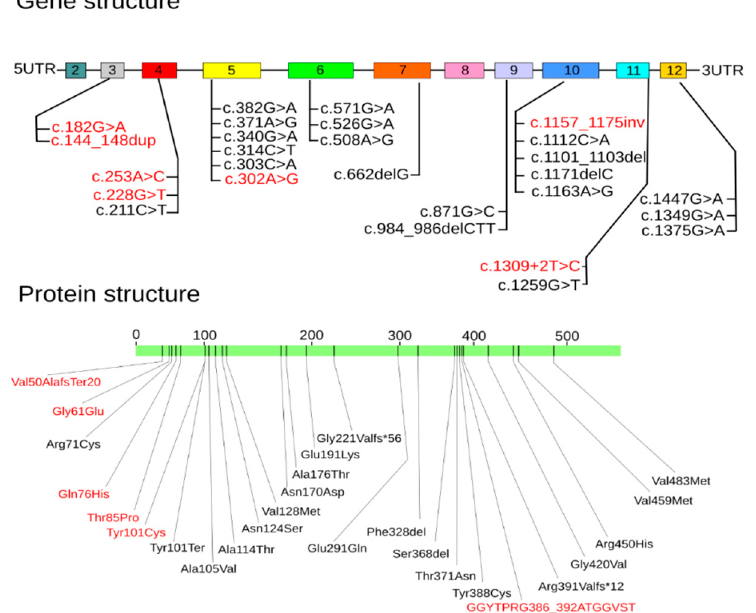
Figure 6. Distribution of genetic variants in the ALPL gene and amino acid substitutions in the TNSALP protein in Russian patients (compound heterozygotes and homozygotes only). Variants are highlighted in red, identified for the first time in the Russian population. patients with the two variants is illustrated in Figure 7.